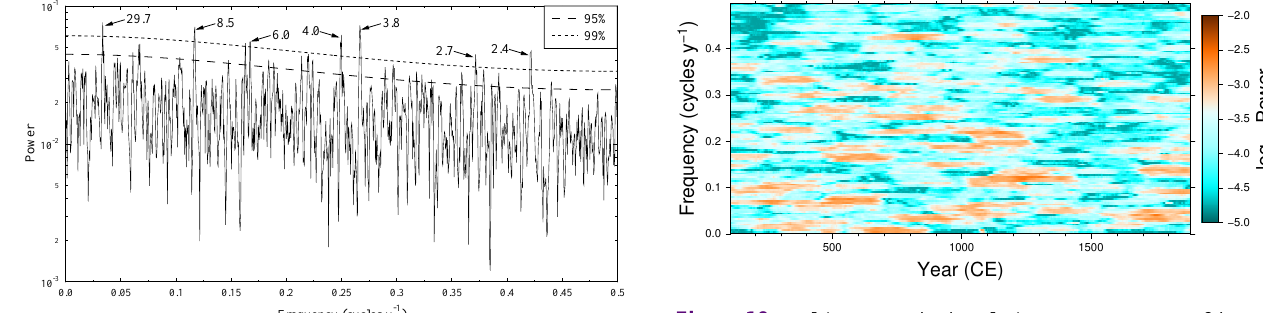
Figure 10. MultiTaper Method evolutive power spectrum of the cal- culated power law DSS snow accumulation rate time series using a resolution of 2 and 3 tapers and a bandwidth of 256 years. Table 2. Correlation between the Law Dome snow accumulation record and shallow ice core records from Queen Maud Land (Fer- nandoy et al.,